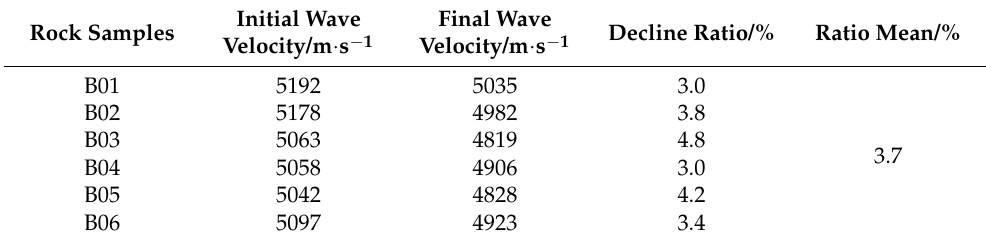
Table 5. Variation of radial wave velocity of rock sample.